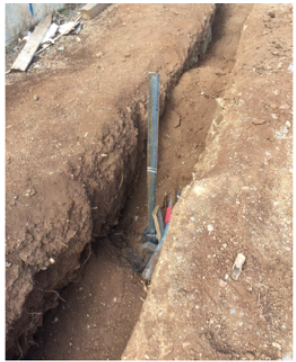
Figure 10. Marker bar installation.